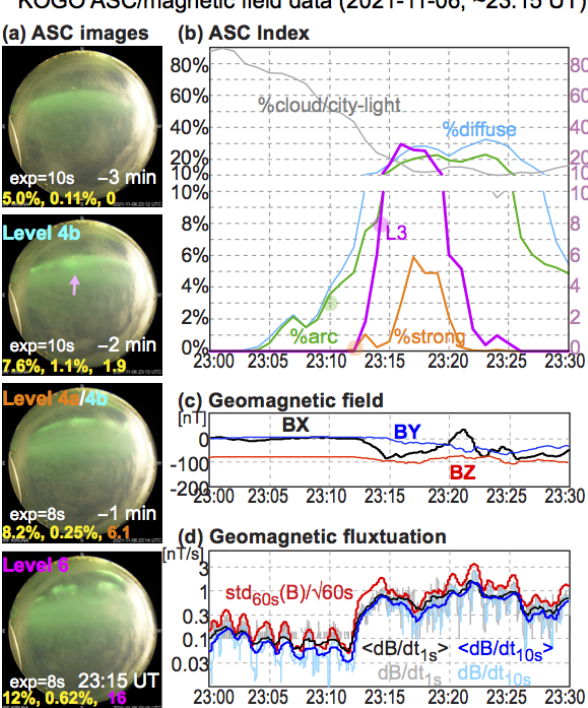
Figure 9. The same as Fig. 8 for the Level 6 auroral activity at 23:15UT on the same night as in Figs. 7 and